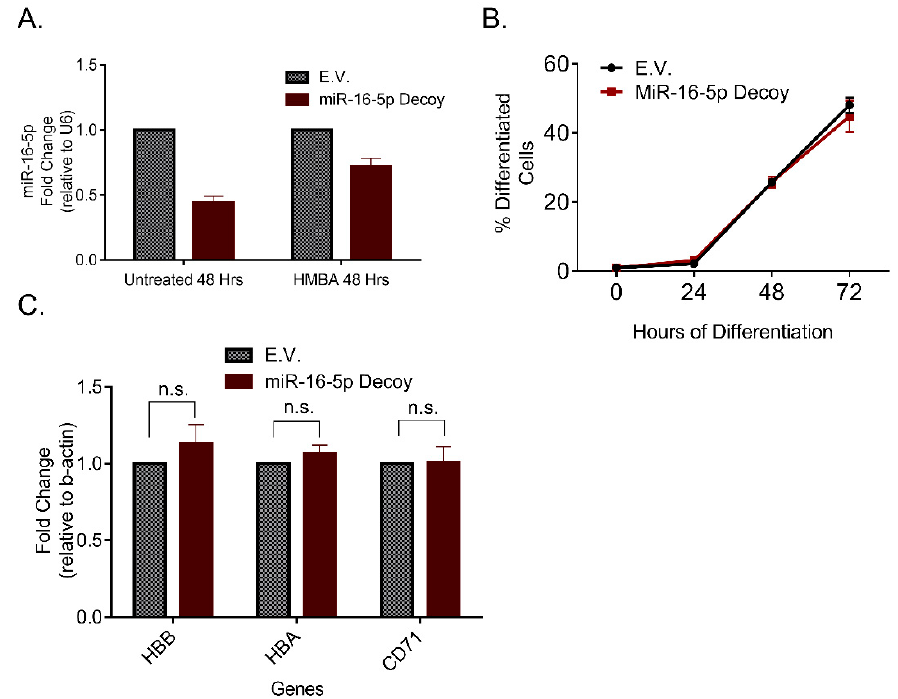
Figure 3. Inhibition of miR-16-5p by a decoy plasmid in MEL cells. ( A ) Quantification of the miR- 16-5p cellular levels after transfection with the decoy plasmid. The experiment was performed exactly as with the mimic plasmid shown in the timeline in Figure 2A, thus, transfection with the decoy plasmid was performed in day-1. ( B ) Percentage of differentiated cells in each culture in a time-dependent experiment. Differentiation was scored using the benzidine positivity assay, which stains hemoglobin-accumulating cells. ( C ) mRNA levels of selected biomarkers of differentiation in E.V. against miR-16-5p decoy treated cells (normalized to β -actin). Statistical analysis was performed using multiple t -tests (Holm–Sidak method) between E.V. and miR-16-5p decoy treated cells and no alteration was found to be statistically significant.